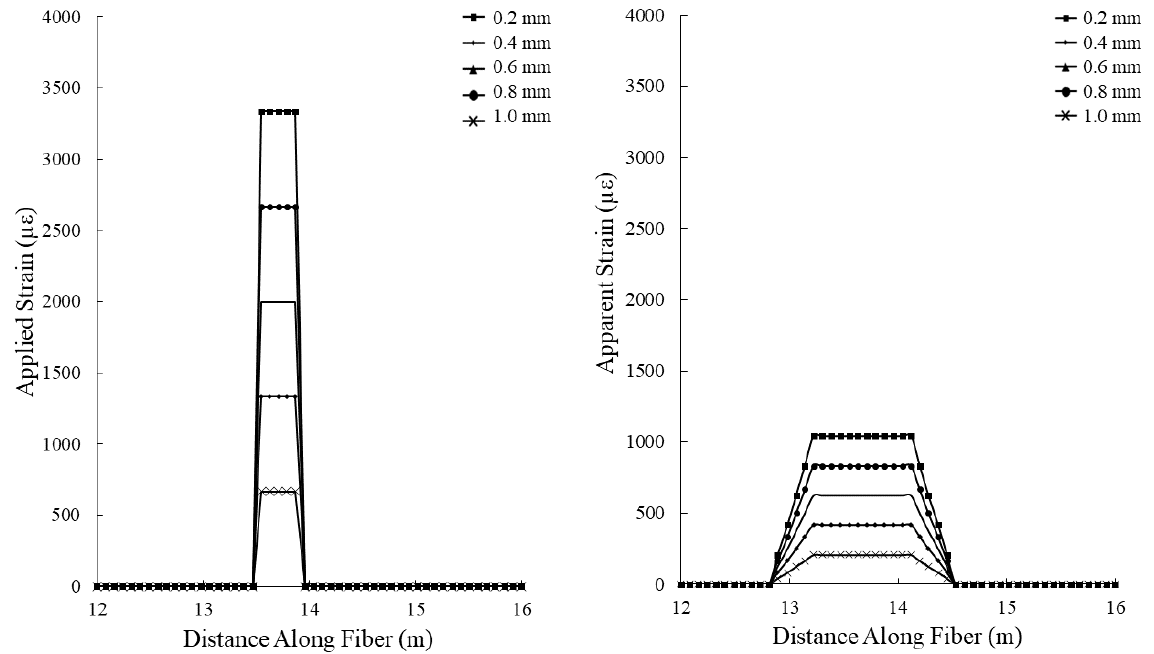
Figure 11. Theoretical applied ( left ) and apparent ( right ) strains incident upon the hybrid optical fiber cable during the tensile deformation experiment. Axial displacements from 0.2 to 1.0 mm. Gauge length is 0.3 m.